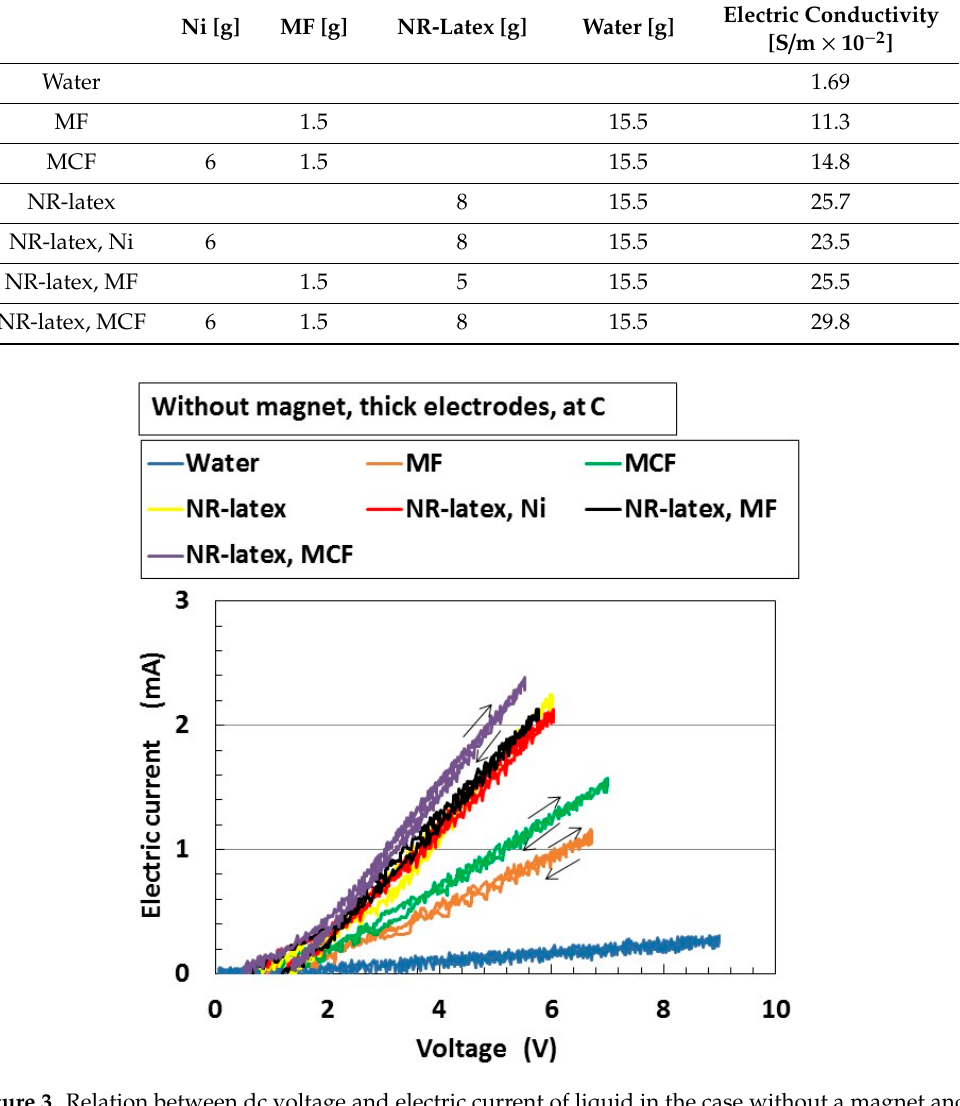
Figure 3. Relation between dc voltage and electric current of liquid in the case without a magnet and using thick electrodes in “C” in Figure 2b.